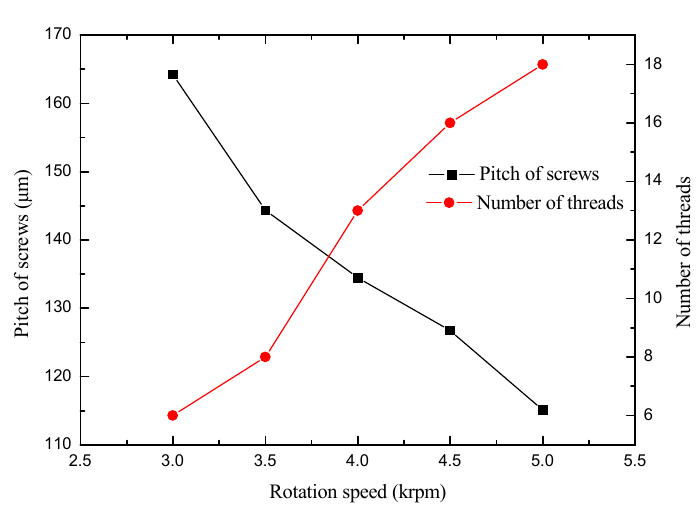
Figure 6. The pitch and the number of screw threads of the spiral electrodes by different rotation speeds.